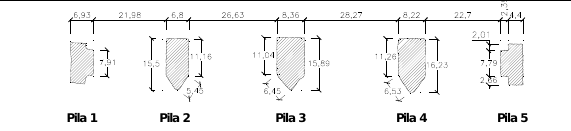
Figure 3. Horizontal sections of the pillars above the start of the arches.